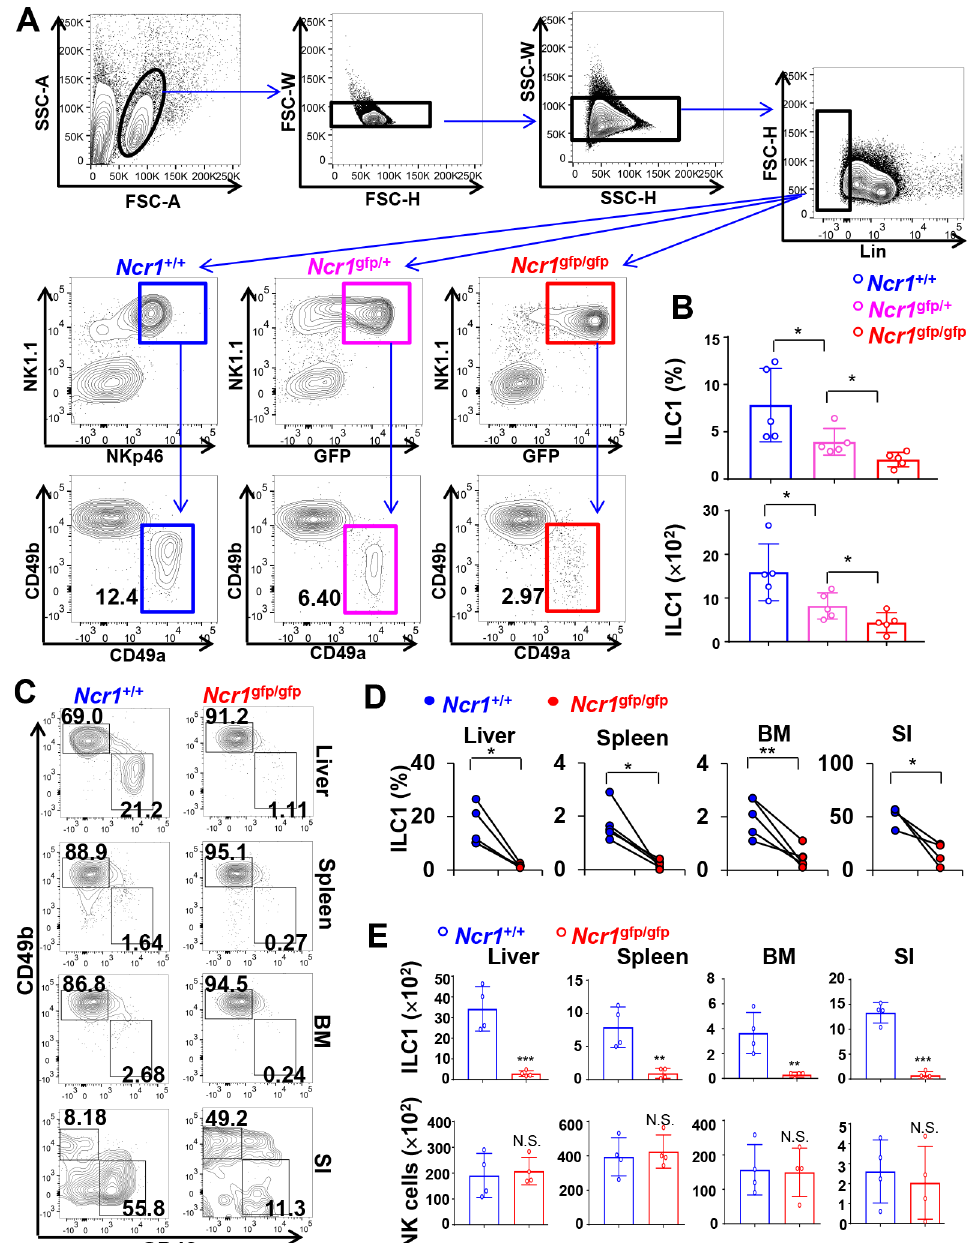
Fig 1. NKp46 is required for ILC1 development. (A) Gating strategy for ILC1s. ILC1s were gated on lymphocytes and then were further defined as Lin − NK1.1 + NKp46 + CD49b ─ CD49a + , with the exception that GFP + was used to replace NKp46 + when Ncr1 gfp/+ or Ncr1 gfp/gfp mice were used. (B) Percentages or quantities of ILC1s were determined by flow cytometric analysis in the liver of Ncr1 gfp/gfp , Ncr1 gfp/+ , and Ncr1 +/+ mice. (C) NK cells were gated on Lin ─ NK1.1 + NKp46 + (or GFP + for Ncr1 gfp/gfp mice)CD49b + CD49a ─ among lymphocytes. ILC1s were gated on Lin ─ NK1.1 + NKp46 + (or GFP + for Ncr1 gfp/gfp mice)CD49b ─ CD49a + among lymphocytes. (D) Quantification of ILC1s in different organs or tissues in Ncr1 gfp/gfp mice and Ncr1 +/+ littermates, i.e., summary data for (C). Each line demonstrates percentages of ILC1s for a pair of Ncr1 gfp/gfp and Ncr1 +/+ littermates. (E) Quantities of NK cells or ILC1s in different organs of Ncr1 gfp/gfp mice and their Ncr1 +/+ littermates ( n = 4). Error bars, standard deviations; (cid:3)(cid:3)(cid:3) , p < 0.001; (cid:3)(cid:3) , p < 0.01; (cid:3) , p < 0.05. The numerical data for panels B, D and E can be found in S1 Data. Lin ─ , CD3 ─ CD19 ─ ; BM, bone marrow; FSC-A, forward scatter area; FSC-H, FSC height; FSC-W, FSC width; GFP, green fluorescent protein; ILC1, innate lymphoid cell 1; NK, natural killer; Ncr1 , natural cytotoxicity receptor 1; SI, small intestine; SSC-A, side scatter area; SSC-H, SSC height; SSC-W, SSC width.